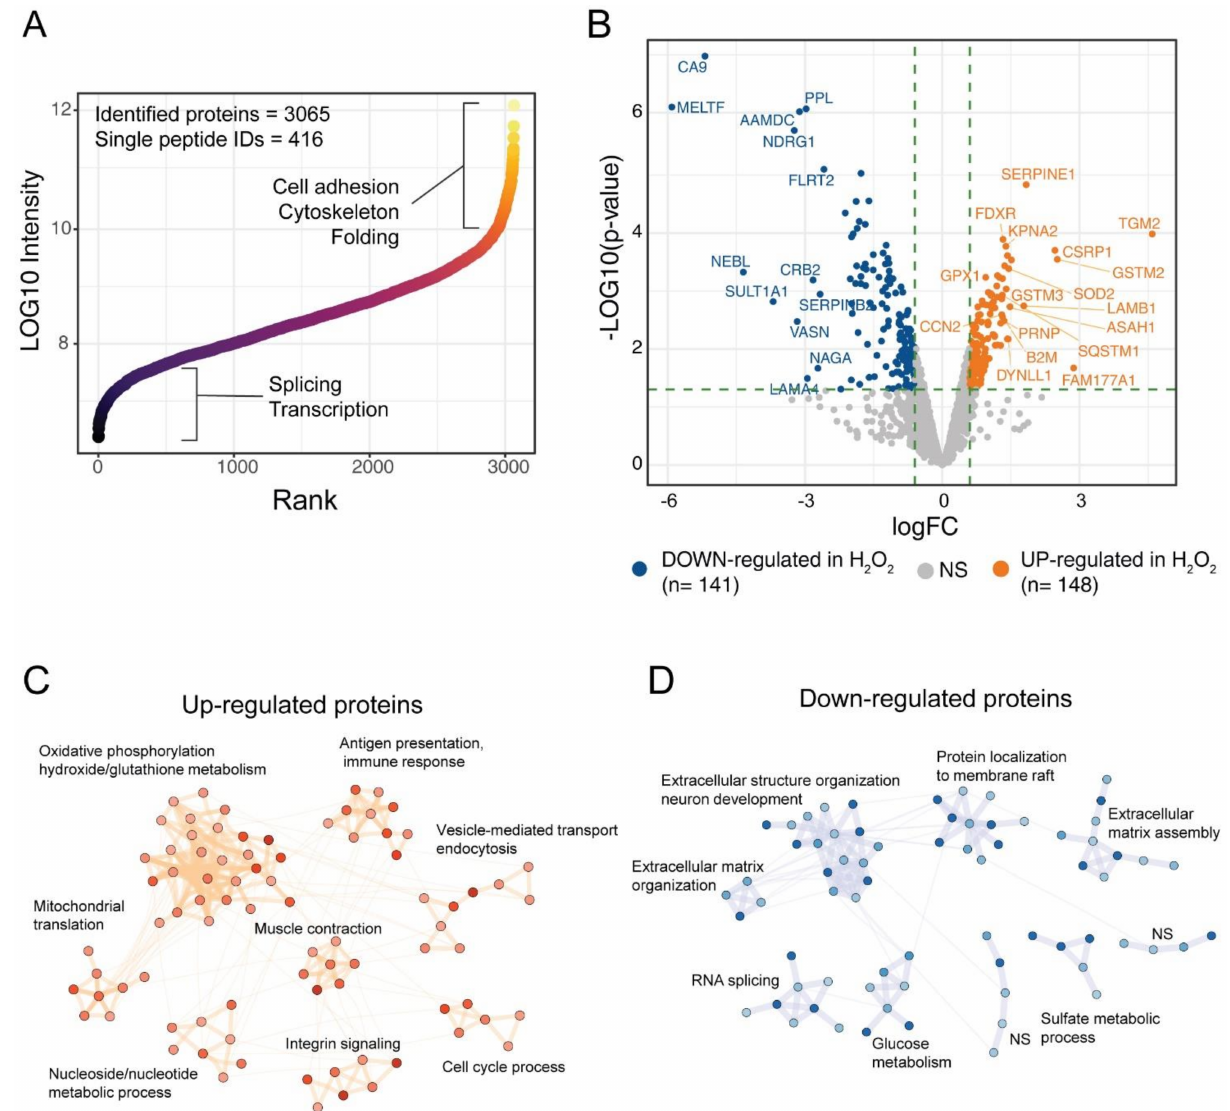
Figure 2. Proteomic analysis of H 2 O 2- treated ARPE cells. ( A ) the scatter plot reports the identified proteins ranked according to intensity values, ~3000 protein groups were identified in ARPE-19 cells, across six orders of magnitude; ( B ) Volcano plot of the differentially expressed proteins upon H 2 O 2 treatment. A total of 148 proteins were up-regulated by H 2 O 2 treatment, while 141 showed down-regulation as compared to control samples; ( C , D ) Network analysis of DE proteins after H 2 O 2 treatment. Networks were retrieved using the STRING database and visualised using the Cytoscape software. Functional enrichment was used to understand which biological processes were enriched in each